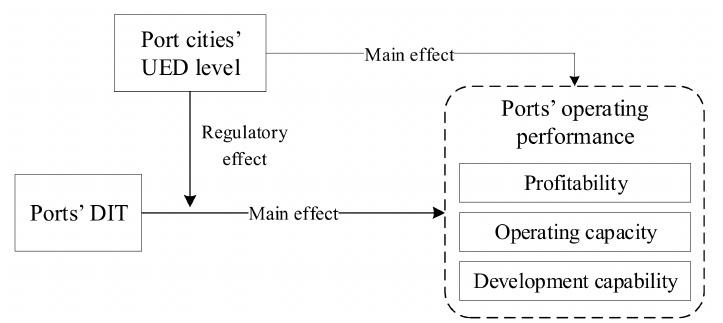
Figure 1. Port enterprise–city relationship.